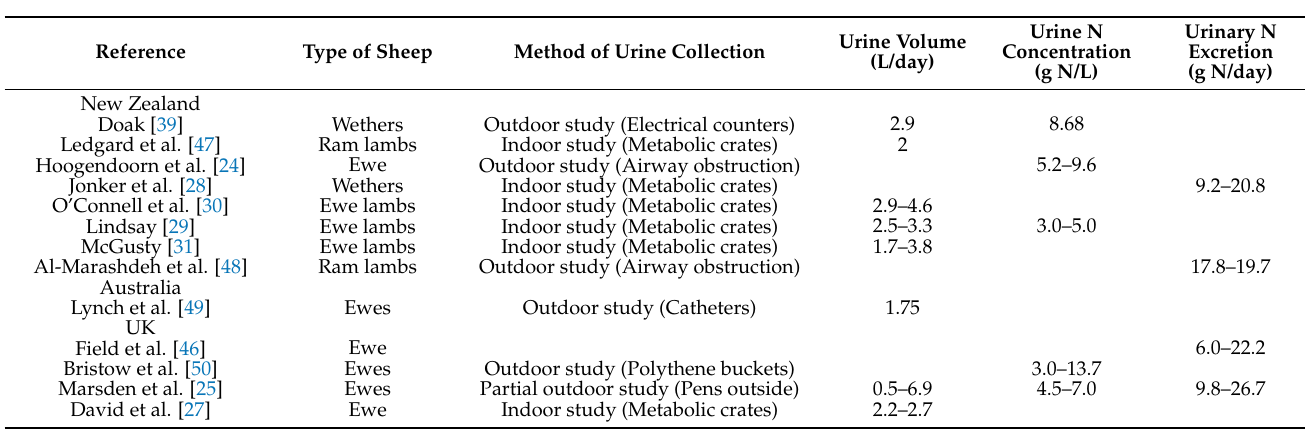
Table 4. Individual and total urine volume (L/day), urine nitrogen (N) concentration (g N/L), and urinary N excretion (g N/day) of sheep grazing pasture measured at various stages using various